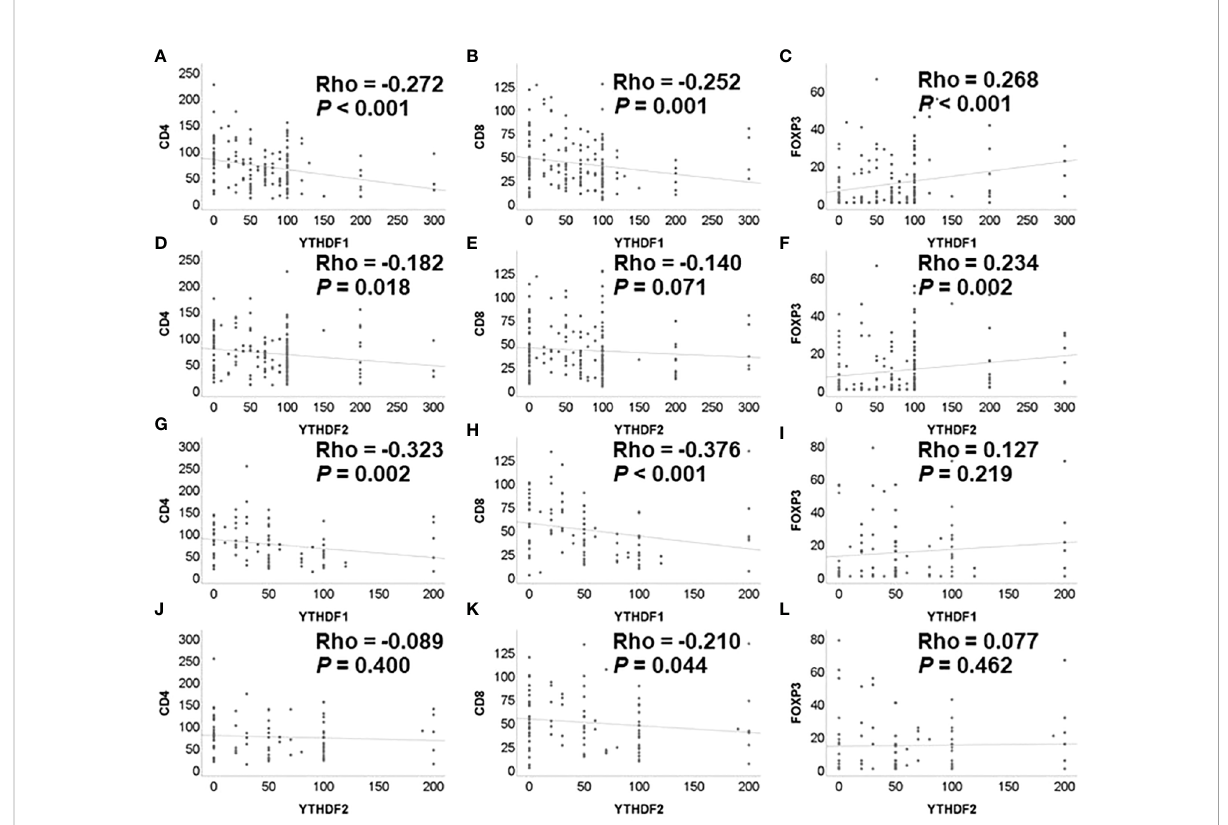
FIGURE 1 Correlation among YTHDF1, YTHDF2, CD4, CD8, and FOXP3 analyzed by immunohistochemistry in PD-1 inhibitor non-treatment groups. (A) YTHDF1 and CD4 in adenocarcinoma. (B) YTHDF1 and CD8 in adenocarcinoma. (C) YTHDF1 and FOXP3 in adenocarcinoma. (D) YTHDF2 and CD4 in adenocarcinoma. (E) YTHDF2 and CD8 in adenocarcinoma. (F) YTHDF2 and FOXP3 in adenocarcinoma. (G) YTHDF1 and CD4 in squamous cell carcinoma. (H) YTHDF1 and CD8 in squamous cell carcinoma. (I) YTHDF1 and FOXP3 in squamous cell carcinoma. (J) YTHDF2 and CD4 in squamous cell carcinoma. (K) YTHDF2 and CD8 in squamous cell carcinoma. (L) YTHDF2 and FOXP3 in squamous cell